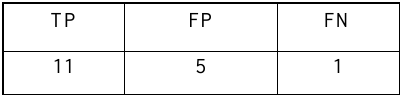
Table 1. Quantitative evaluation of proposed